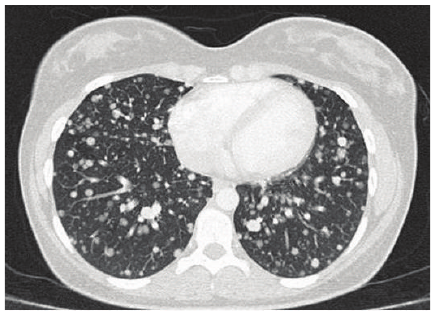
Figure 2: In thoracic CT, multiple atypically located nodule forma- tions are seen in bilateral